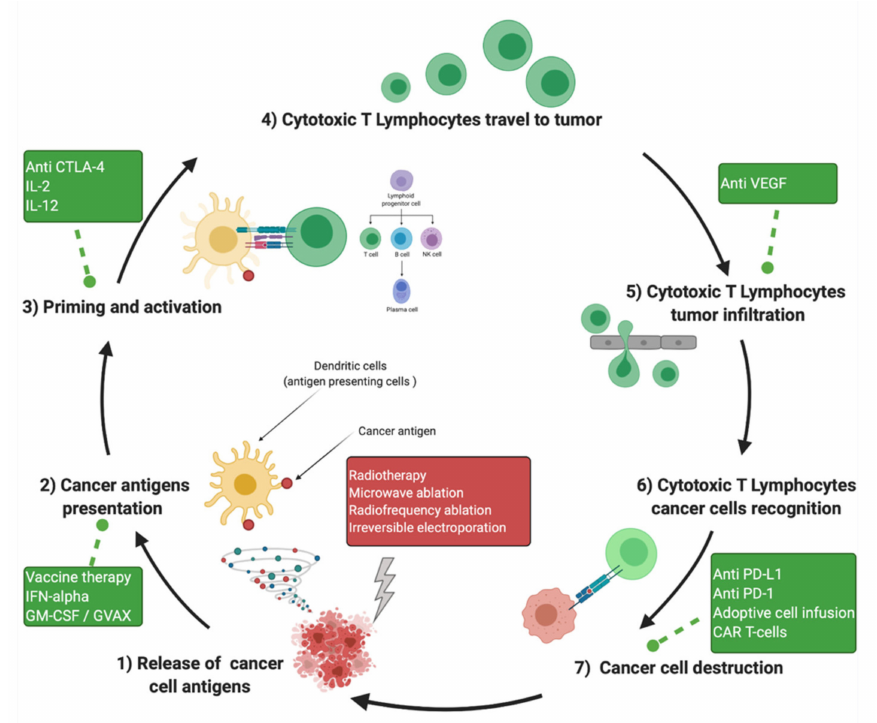
Figure 3. Cancer immunity cycle and immunotherapy intervention at different steps of the antitumor response. Created with BioRender.com accessed on 20 December 2021. GM-CSF: Granulocyte- Macrophage Colony Stimulating